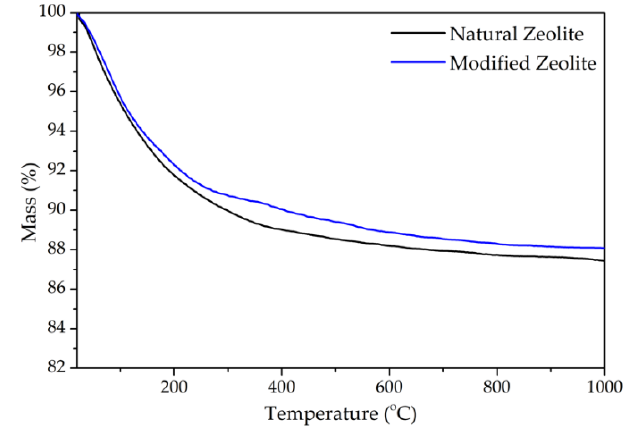
Figure 4. TG curves of natural and modified zeolite.